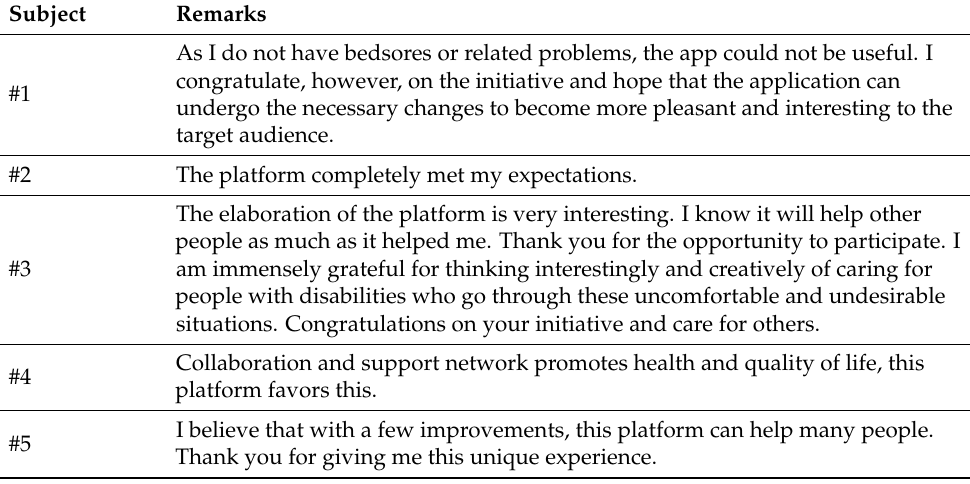
Table 7. Post-experimental